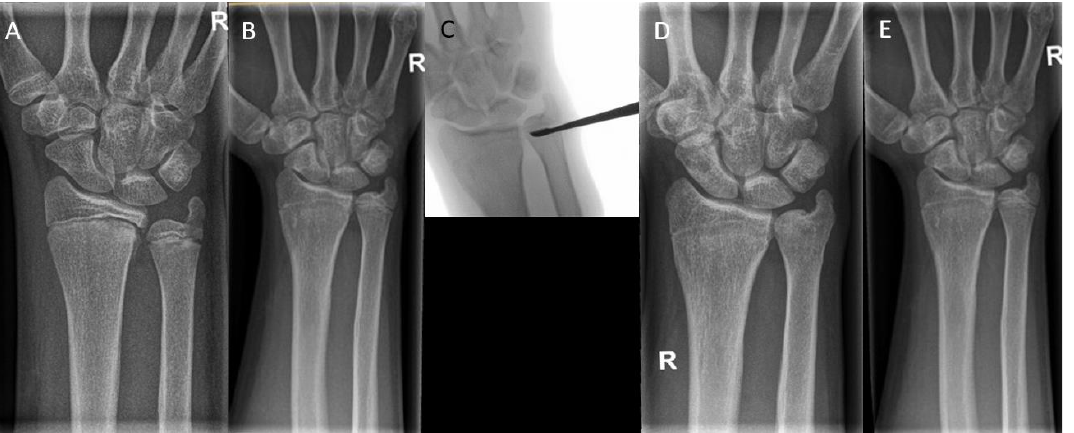
Figure 8. ( A ) A 15-year-old boy with premature closure of the distal radial physis after a Salter – Harris type 2/4 fracture. Initially, the boy had an ulna minus wrist. ( B ) A closed radial physis, accompanied by an impending ulna plus. ( C ) Intraoperative radiographs during epiphysiodesis of the ulna. ( D ) Postoperative radiographs show a closed physis of both the radius and the ulna. Note that the ulna had been growing until the epiphysiodesis, leading to an ulna zero. ( E ) Radiographs after 1-year follow-up. Note the unaltered ulnar variance.